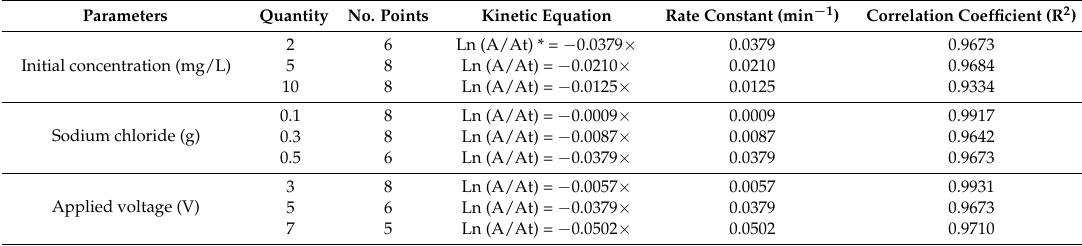
Table 2. Pseudo first order rate constants for hydrochlorothiazide under different conditions such as initial concentration, sodium chloride concentration and applied